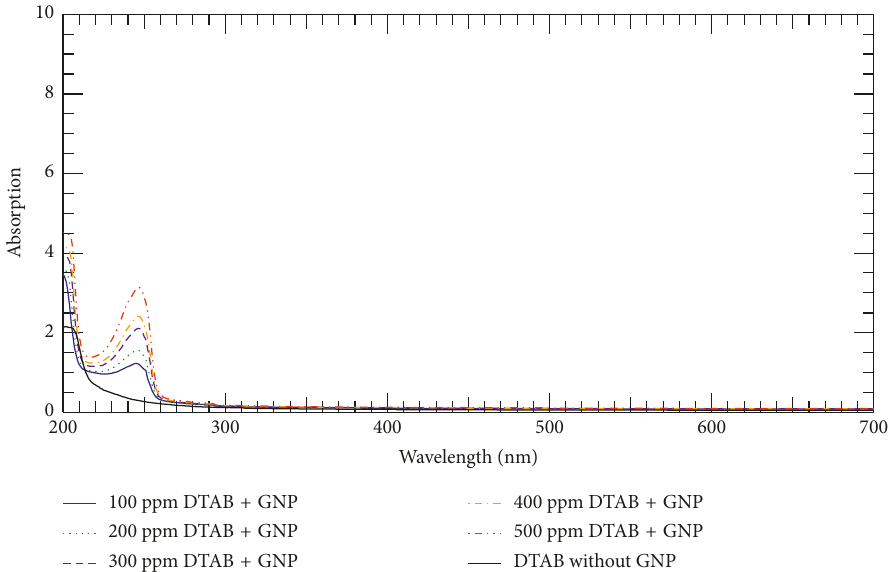
Figure 5: UV-Vis spectra of graphene nanoplatelets in DTAB solutions after 30-minute ultrasonication.